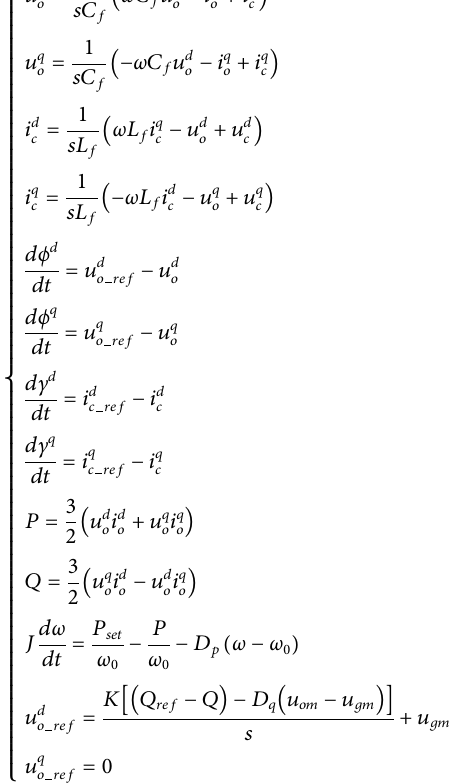
FIGURE 5 Sigmoid-based adaptive inertia regulation curve under different k